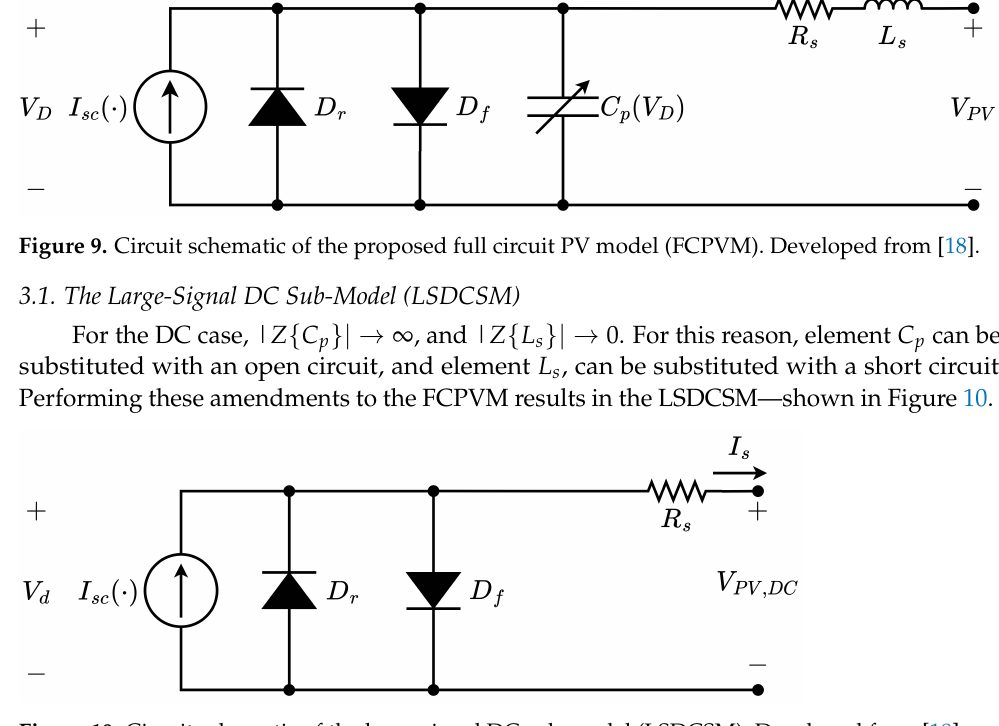
Figure 10. Circuit schematic of the large-signal DC sub-model (LSDCSM). Developed from